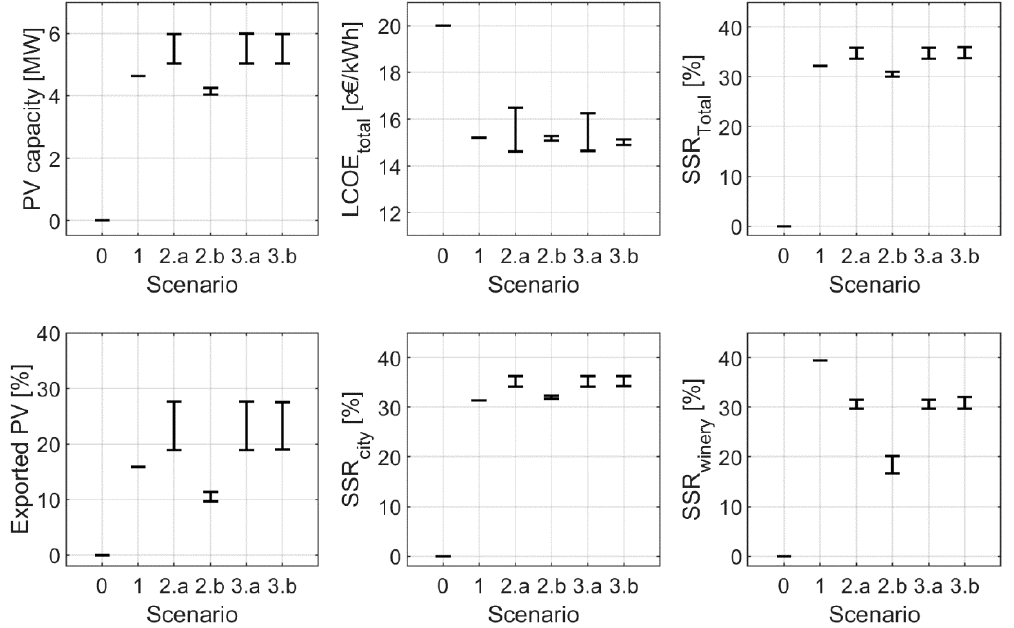
Figure 14. Comparison of the various scenarios presented throughout this work (cf. Section 3.2.5). The vertical dispersion of values for scenarios result from the testing various LV-MV grid tariff values.